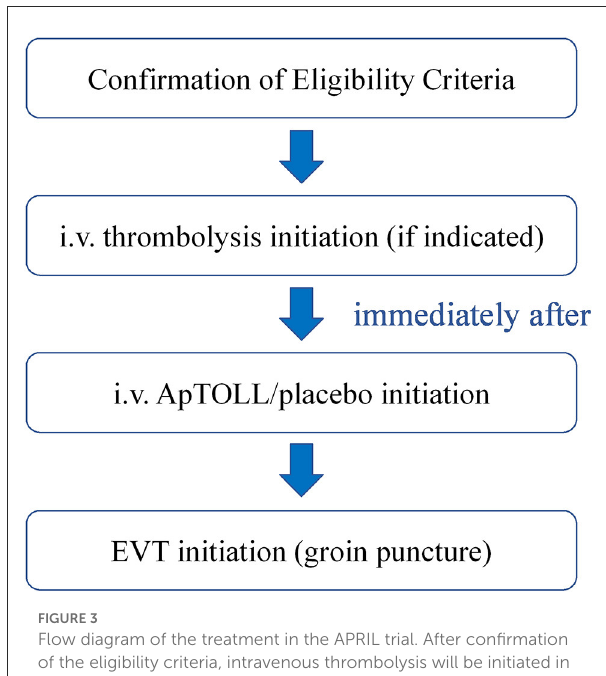
FIGURE3 Flow diagram of the treatment in the APRIL trial. After confirmation of the eligibility criteria, intravenous thrombolysis will be initiated in those patients where indicated. Then, ApTOLL/placebo infusion will start, and the groin puncture will be performed immediately